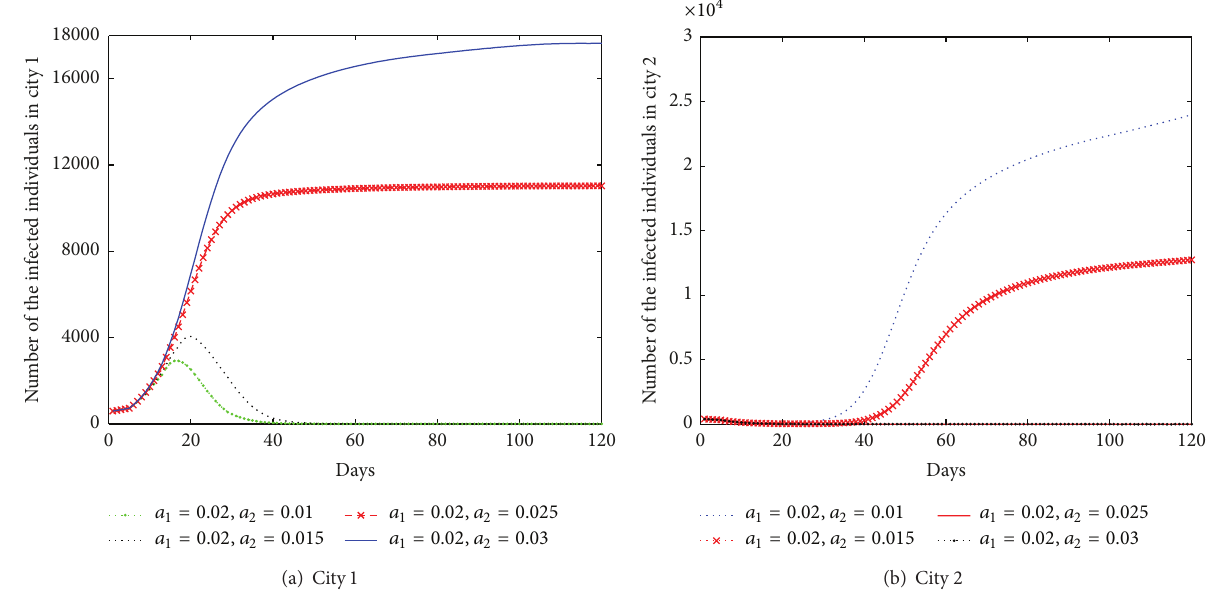
Figure 5: Number of the infected individuals versus different 𝑎 1 and 𝑎 2